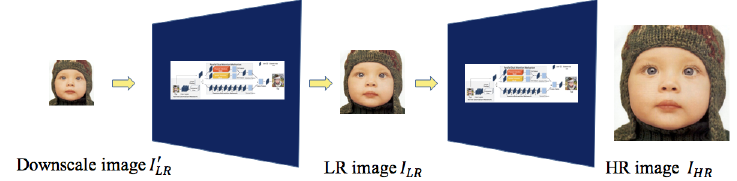
Figure 1. Self-learning architecture.